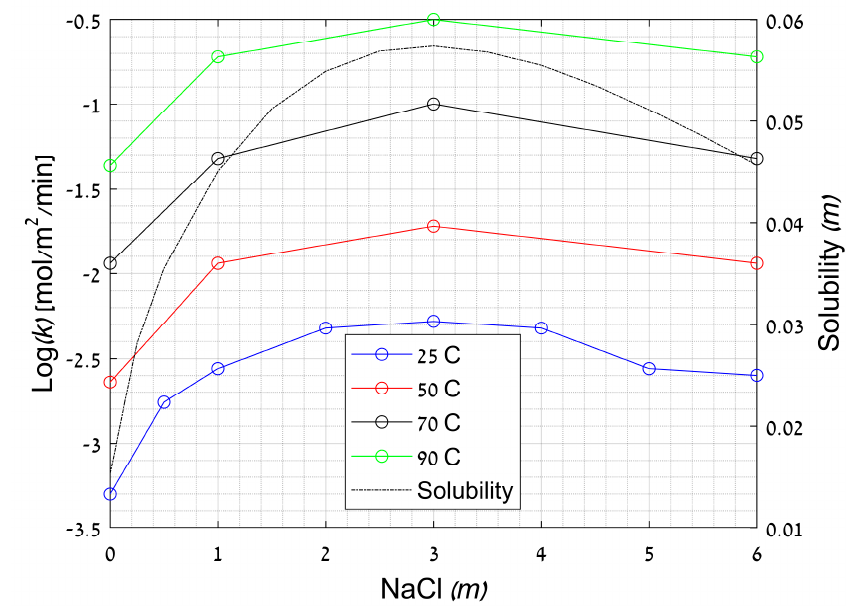
Figure 8. Gypsum solubility (at 25 °C) and logarithm of rate coefficients for gypsum growth at a range of temperatures (25 °C, 50 °C, 70 °C, and 90 °C) in stoichiometric solutions as a function of salinity (0–6 m ). Note that over the range of temperature presented, the rate coefficient increases and decreases with solubility. Rate coefficients are from He et al. [71]; solubility was calculated with PHREEQC (see also Figure